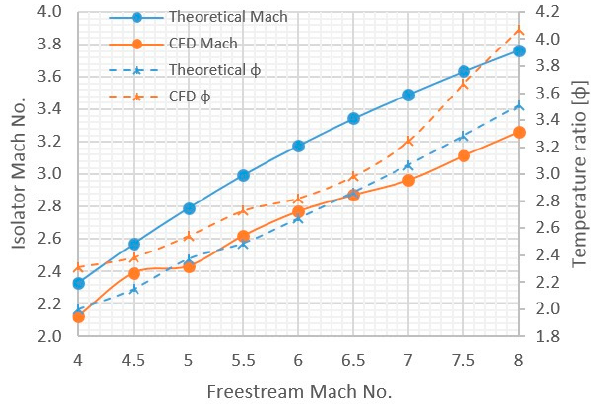
Figure 26. Graph comparing theoretical parameters with 2-D CFD results.